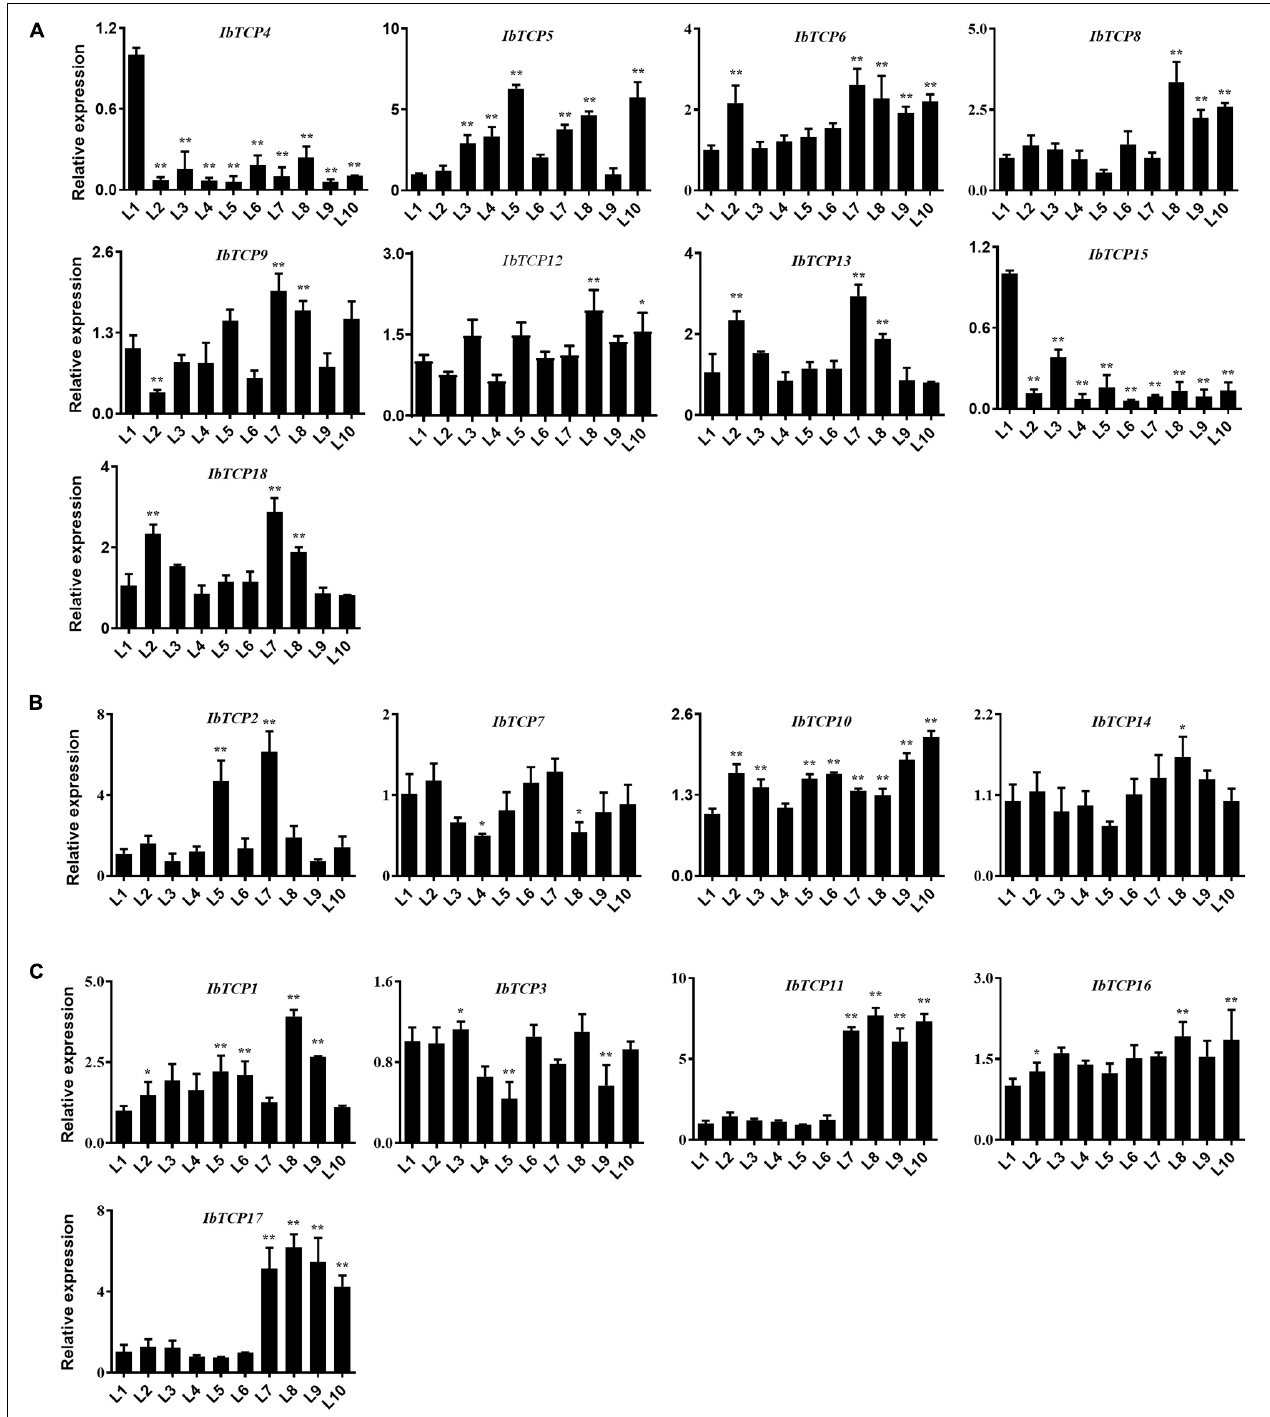
FIGURE 5 | Expression pattern analysis of IbTCPs in varying leaf developmental periods. The qRT-PCR transcript analysis of IbTCPs of Class I (A) , Class II CIN clade (B) , and CYC/TB1 clade (C) in the 1st, 2nd, 3rd, to 10th leaf (L1–L10). The expression profiles were normalized using IbActin . Values are the mean and SD of three replicates. The asterisks indicate statistical significance to L1 (Student’s t -test; * P < 0.05, ** P < 0.01).